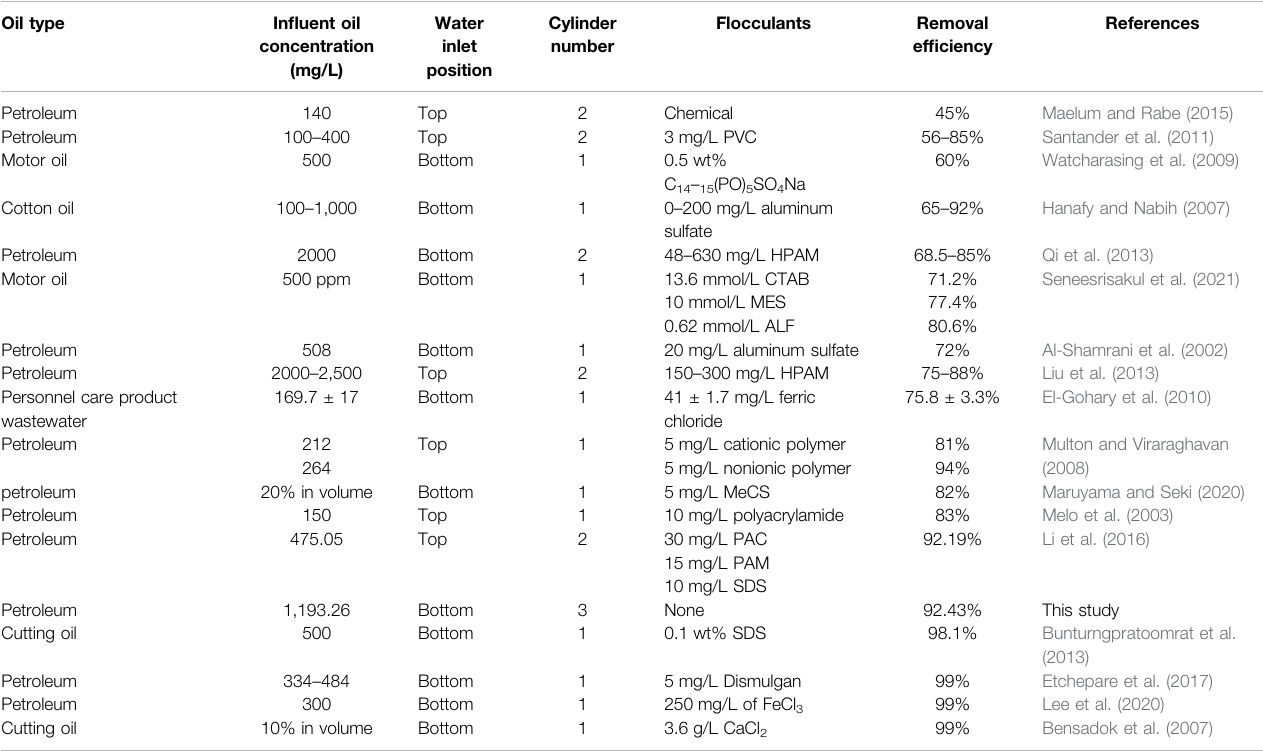
TABLE 1 | Characteristics of fl otation